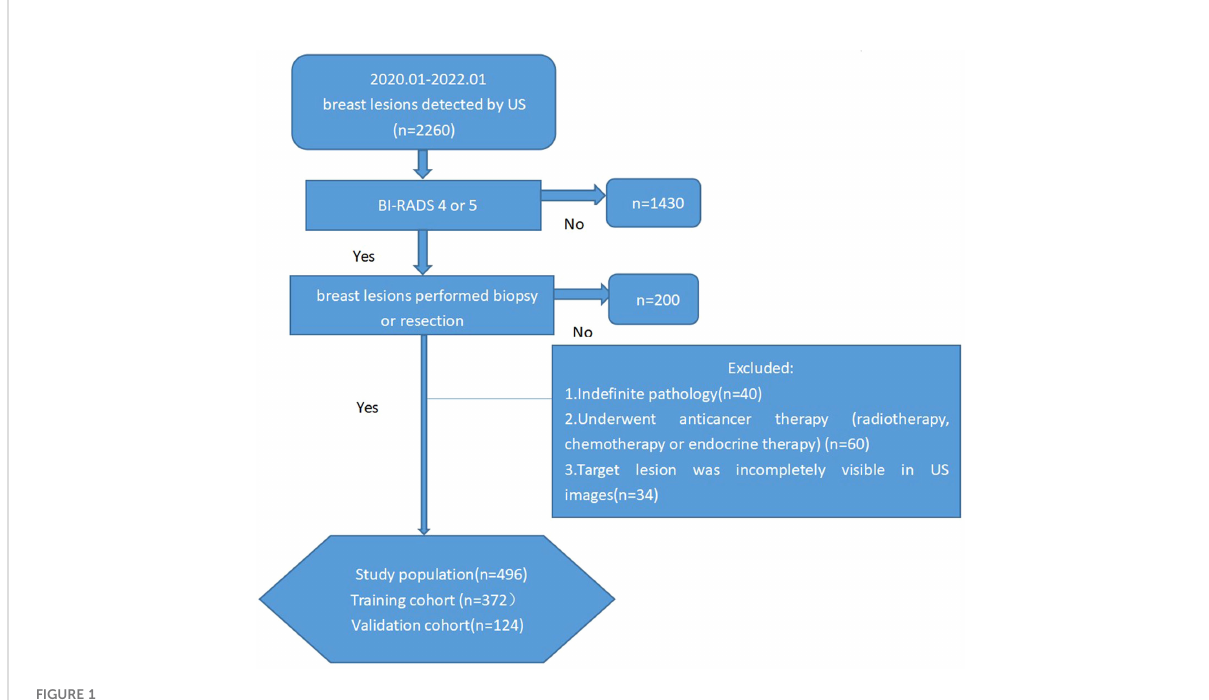
FIGURE 1 Flow chart of the study population